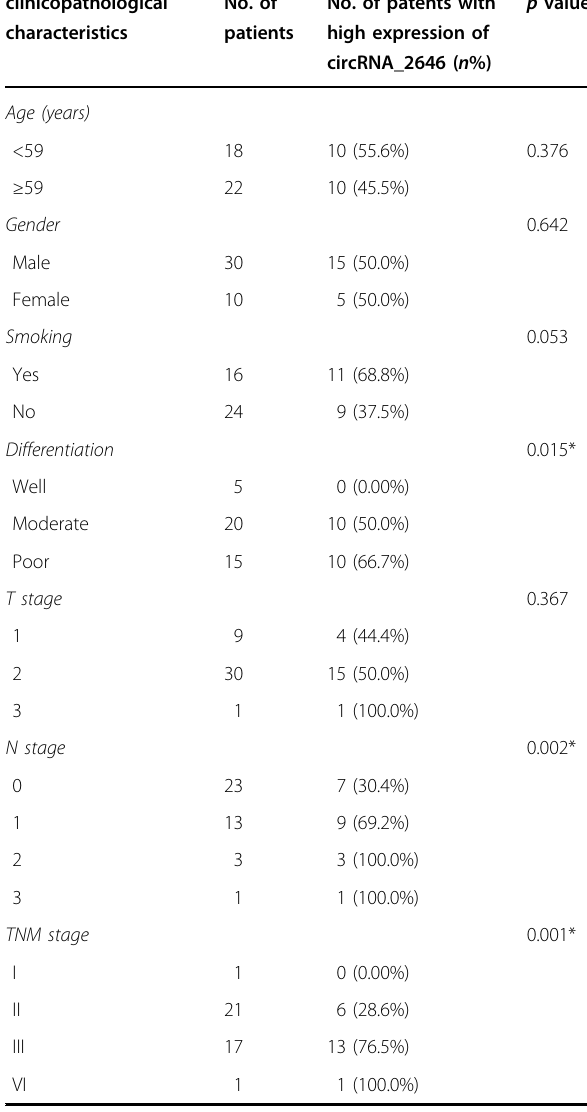
Table 1 Correlation between circRNA_2646 expression and clinicopathological characteristics in ESCC patients ( n =